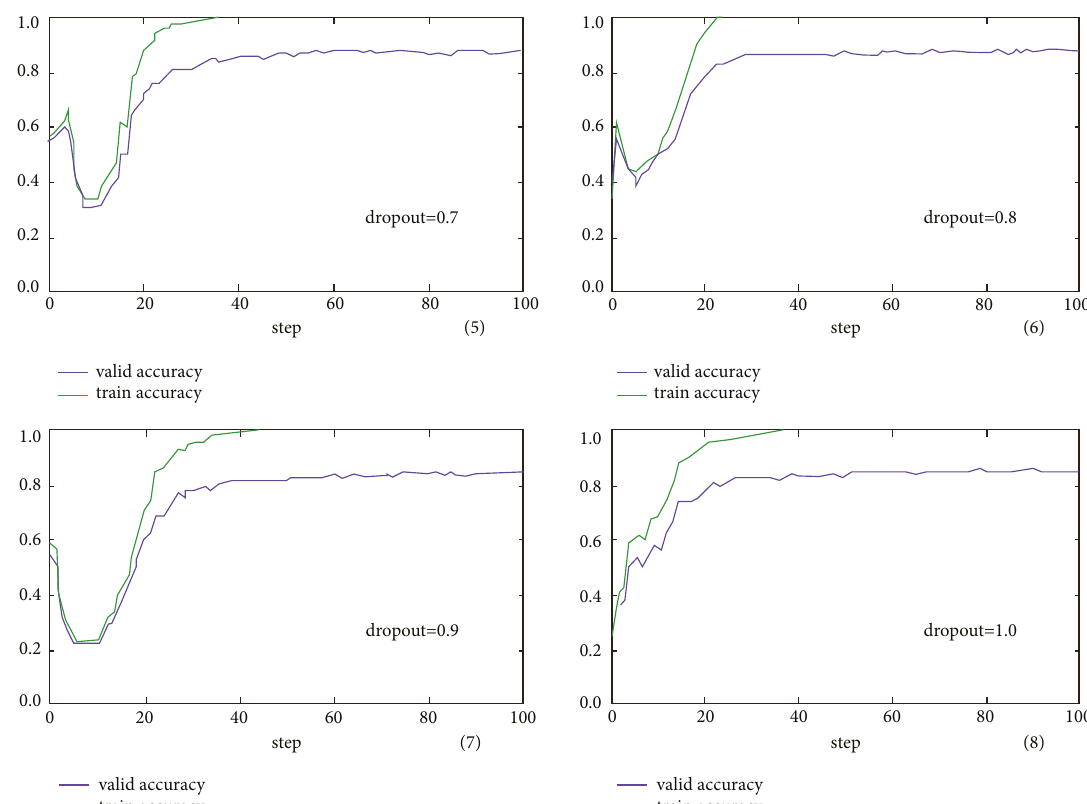
Figure 16: Changes of correct rate under different dropout in training process